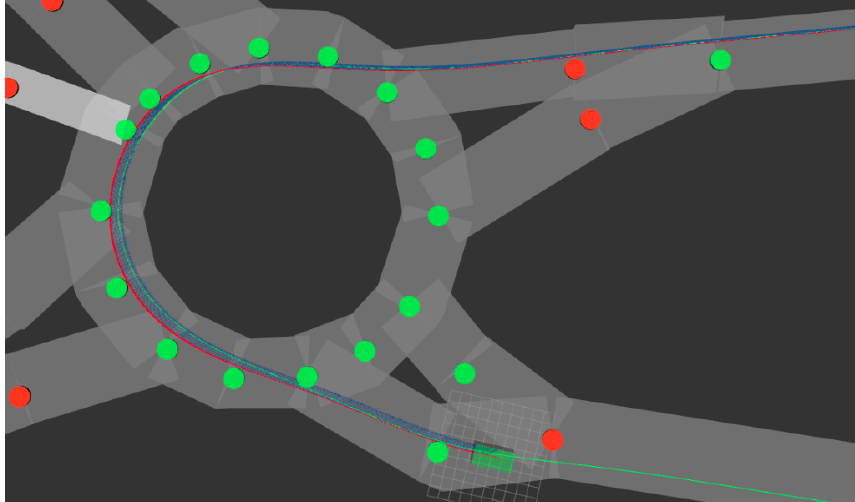
Figure 12. Results of testing the simulated Autonomous Testing Platform for Insurance Research (ATLAS) inside a digital copy of Avila’s road network. In green: the path to follow, in blue: the GNSS odometry, in red: the unscented Kalman filter (UKF) localization